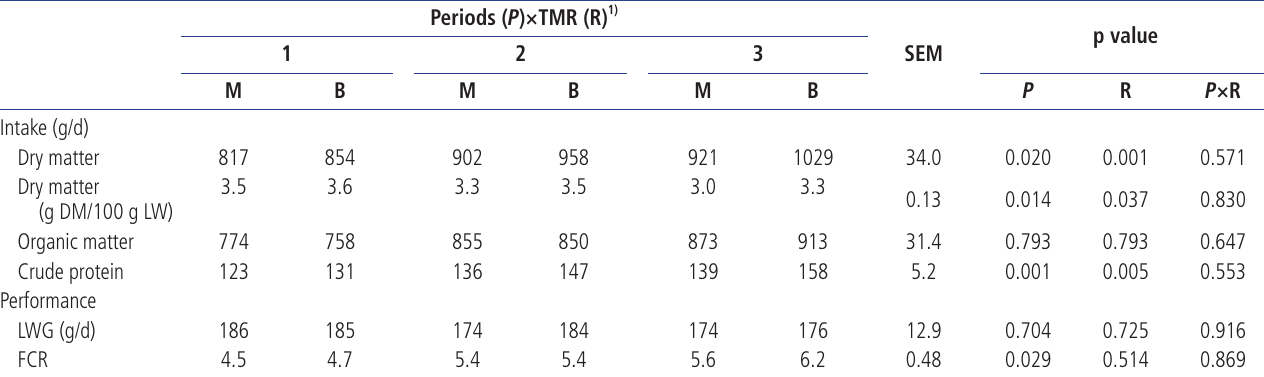
Table 3. Dry matter and nutrient intake, and performance of lambs fed maize TMR or buckwheat TMR Periods (P)×TMR (R) 1)